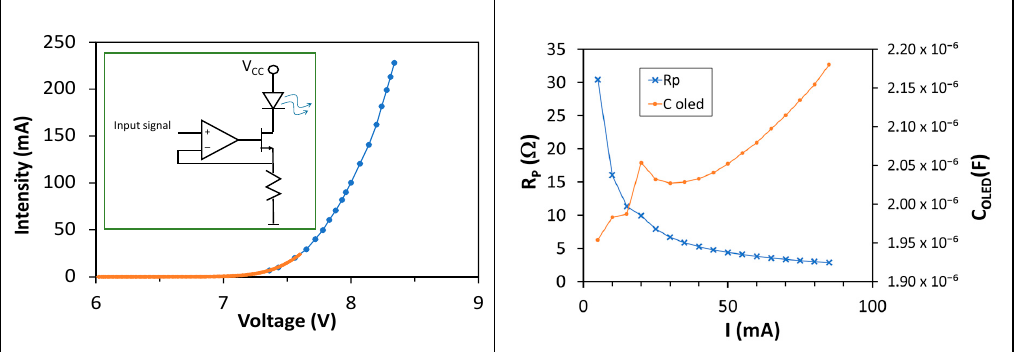
Figure 9. ( Left ) I-V curve measured with two methods: Gamry potentiostat (orange dots) and customized circuit (blue dots, inset). ( Right ) Circuital parameters of the equivalent circuit of the OLED (inset) versus the applied current obtained using impedance spectroscopy.